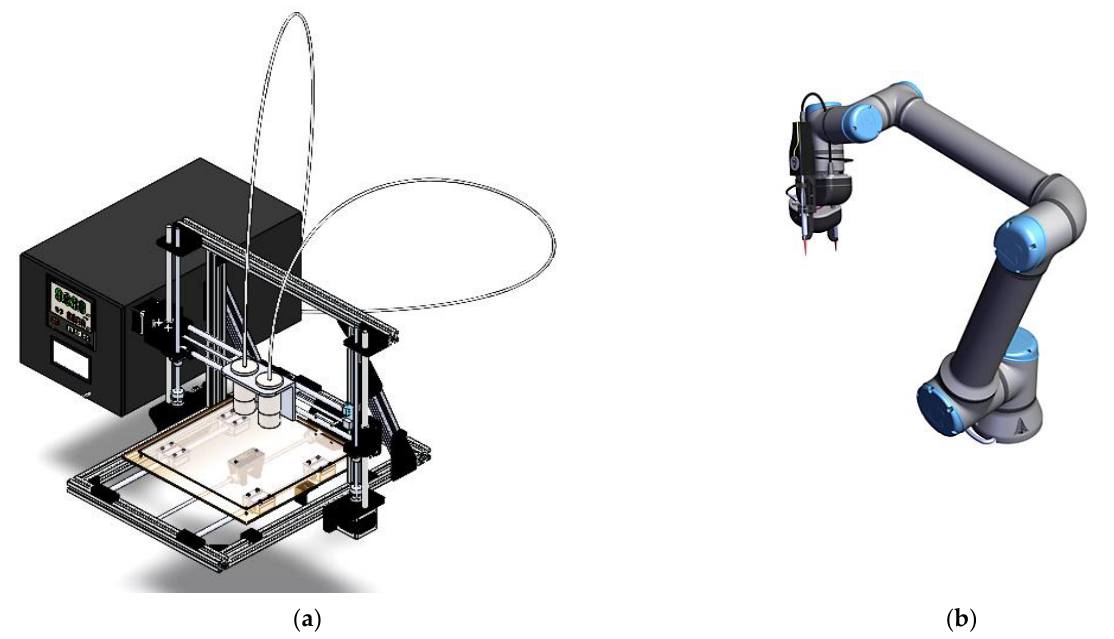
Figure 6. Schematic view of DTU Wind and Energy Systems 3D printers: ( a ) Cartesian table-based platform and ( b ) robot arm-based platform.